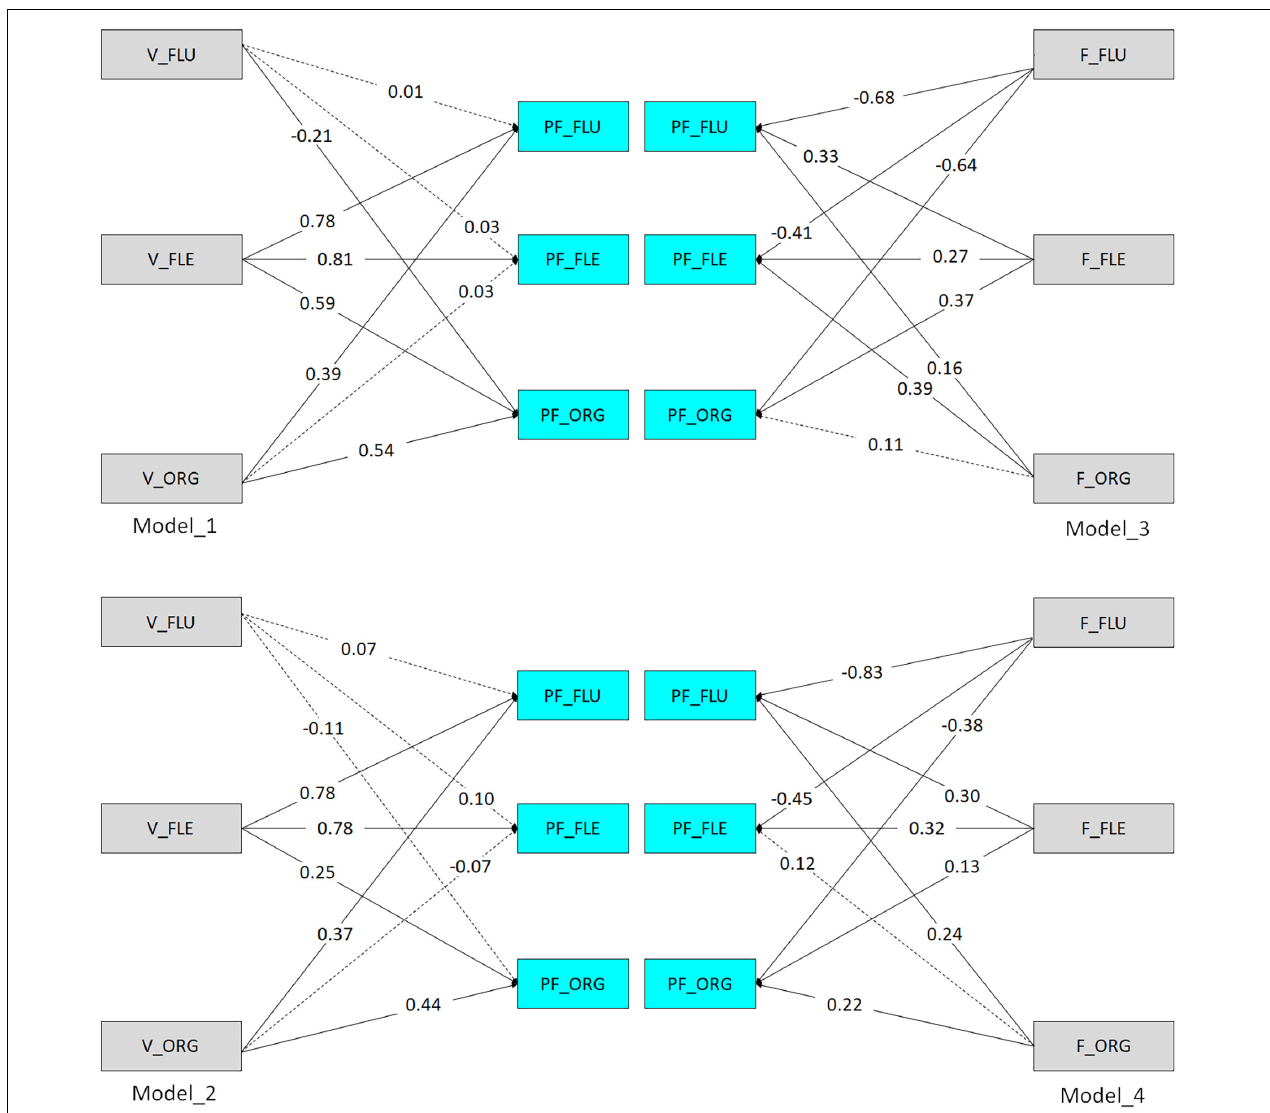
FIGURE 2 | Path analysis models for the study variables. V, verbal; F, figural; PF, problem finding; FLU, fluency; FLE, flexibility; ORG, originality.